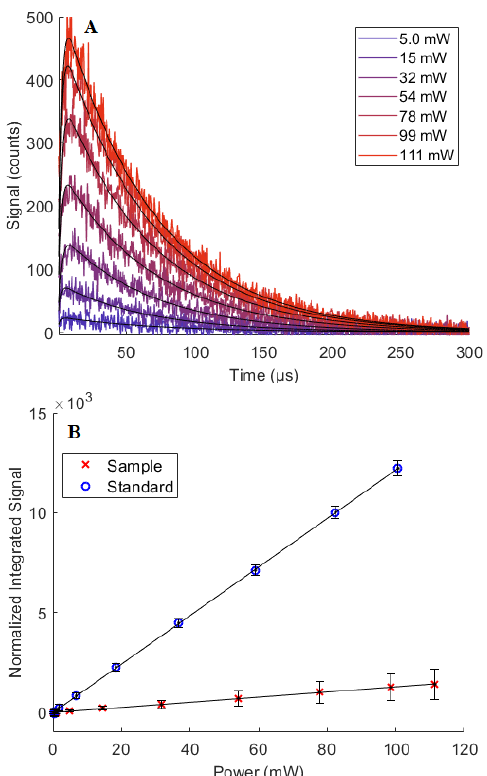
Figure 6. ( A ) Representative time-resolved O 2 (a 1 Δ g ) → O 2 (X 3 Σ g− ) phosphorescence traces recorded at 1275 nm upon 420 nm pulsed laser irradiation of Athens Green in air-saturated D 2 O at pD = 5.0. For the triplet state photosensitized production of O 2 (a 1 Δ g ) in water, where the concentration of oxygen is comparatively low, it is common to discern a rise in the time-resolved signal corresponding to the comparatively slow rate of O 2 (a 1 Δ g ) production. Such data are quantified using a difference of two exponential functions [27,39], and this fitting function is superimposed on each kinetic trace. ( B ) The integrated signal amplitude, normalized by the O 2 (a 1 ∆ g ) lifetime, τ ∆ , and the sample absorbance, plotted as a function of the incident laser power. The slopes of the linear fits are proportional to ϕ ∆